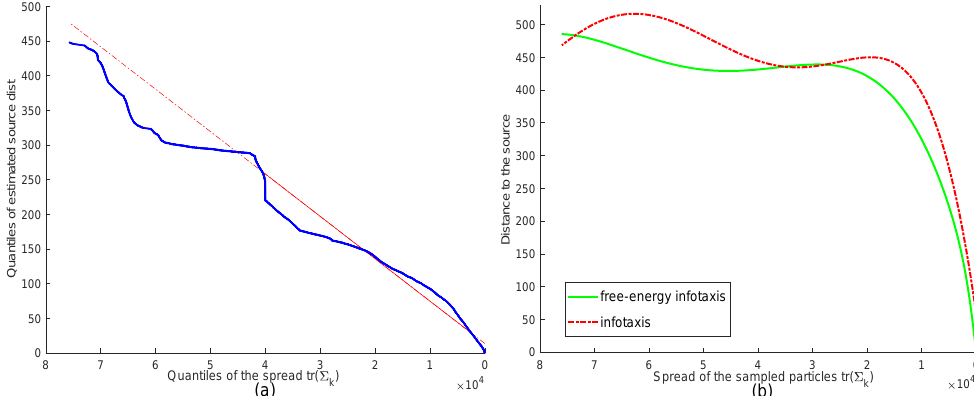
Figure 5. ( a ) Q-Q plot of the distance between the estimated source and the real source versus the inverse of the spread of the sampled particles. ( b ) The distance of the sensor position and the real source using the infotaxis scheme versus the free energy infotaxis scheme (curve fitting the data). The source location was fixed at [ − 250, 0] and the initial sensor position at [200, −